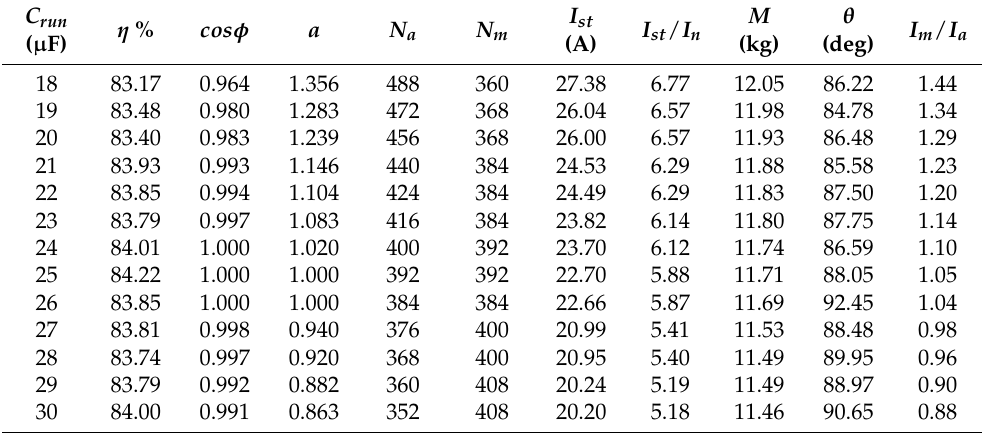
Table 6. Design parameters and performance quantities of the SPIMs with rotor bars of polygonical shape.